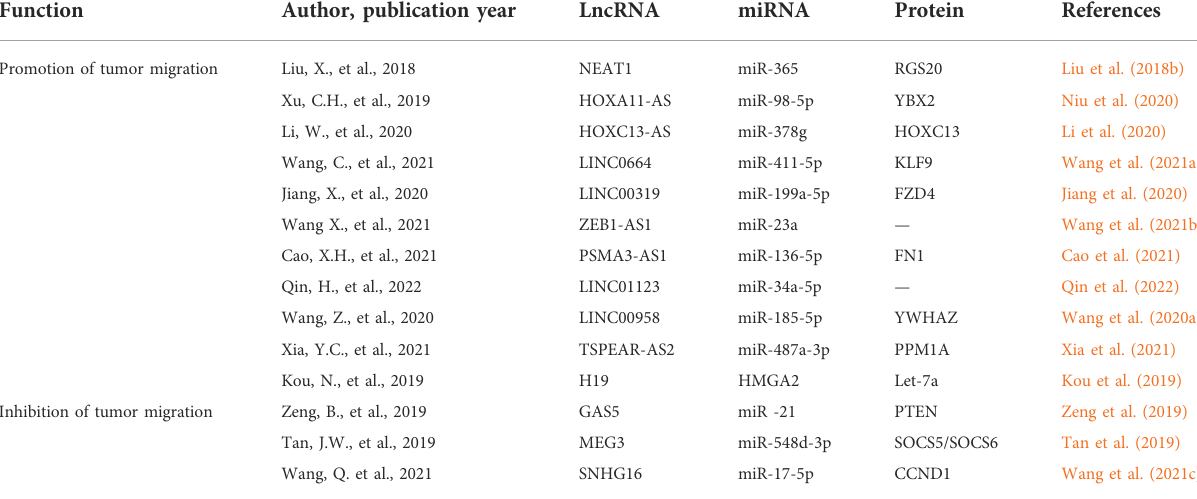
TABLE 2 LncRNAs interact with miRNAs in OSCC cells to shape the EMT induction.